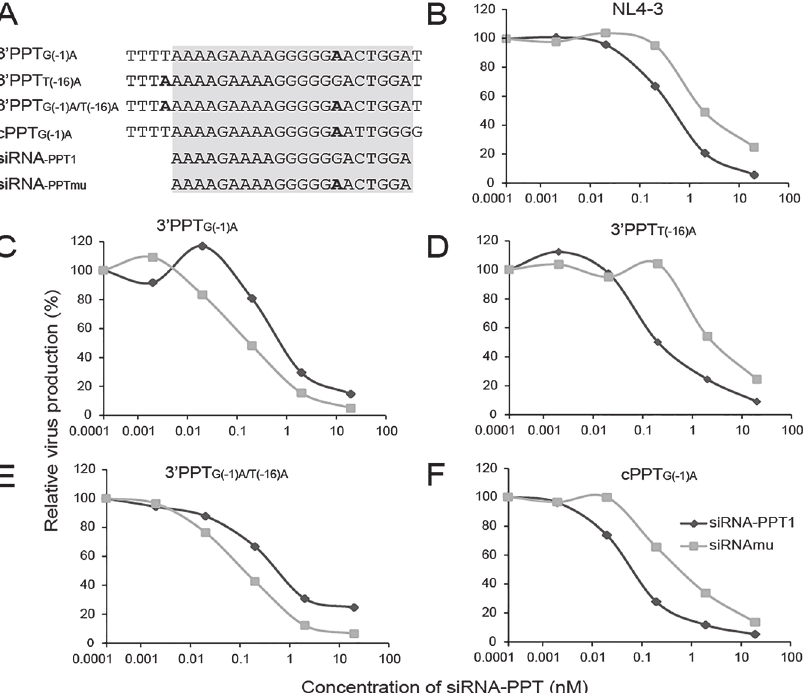
Fig 4. Sensitivity of 3 0 PPT and cPPT mutant viruses to siRNA-PPT1 and siRNA-PPTmu. (A) PPT and flanking sequences of infectious 3 0 PPT and cPPT mutants together with siRNA-PPTmu. (C)-(F) Sensitivities of infectious PPT mutants to siRNA-PPT1 and siRNA-PPTmu: (C) 3 0 PPT G(-1)A , (D) 3 0 PPT T(-16)A (E) 3 0 PPT G(-1)A/T(-16)A and (F) cPPT G(-1)A . (B) Sensitivity of wild-type NL4-3 to siRNA-PPT1 and siRNAmu. Data was based on three independent